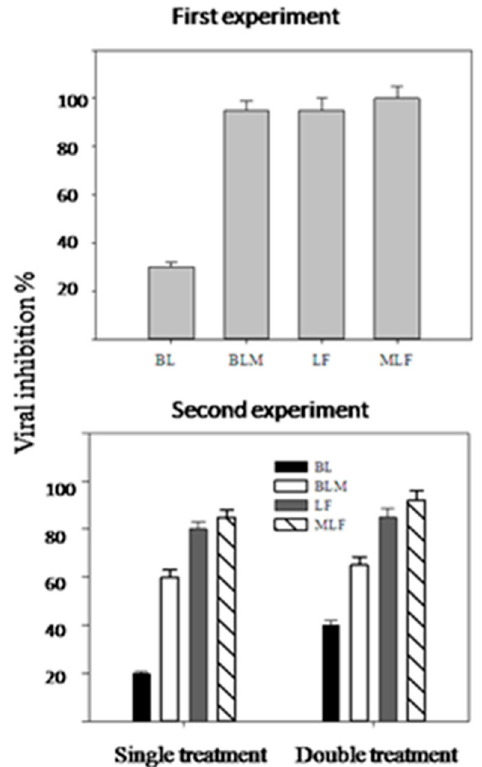
Figure 2. Inhibition of PVY replication in potato plants by application of different milk proteins at a single treatment of 500 µ g mL − 1 distilled water after 15 days of infection. The antiviral action was measured after 21 days of treatment by double antibody sandwich enzyme linked immunosorbent assay (DAS-ELISA) (First experiment). The second experiment followed the design of the first experiment except that plants were sprayed either once (after 10 days) or twice, after 10 and 20 days of viral infection, and the plant samples were assayed for virus load after 21 and 31 days of the first spray. Six representative plant samples out of a total of 15 plants / treatment were used in this analysis and the results are expressed as the means ± SE. Viral inhibition is calculated according to the following equation: